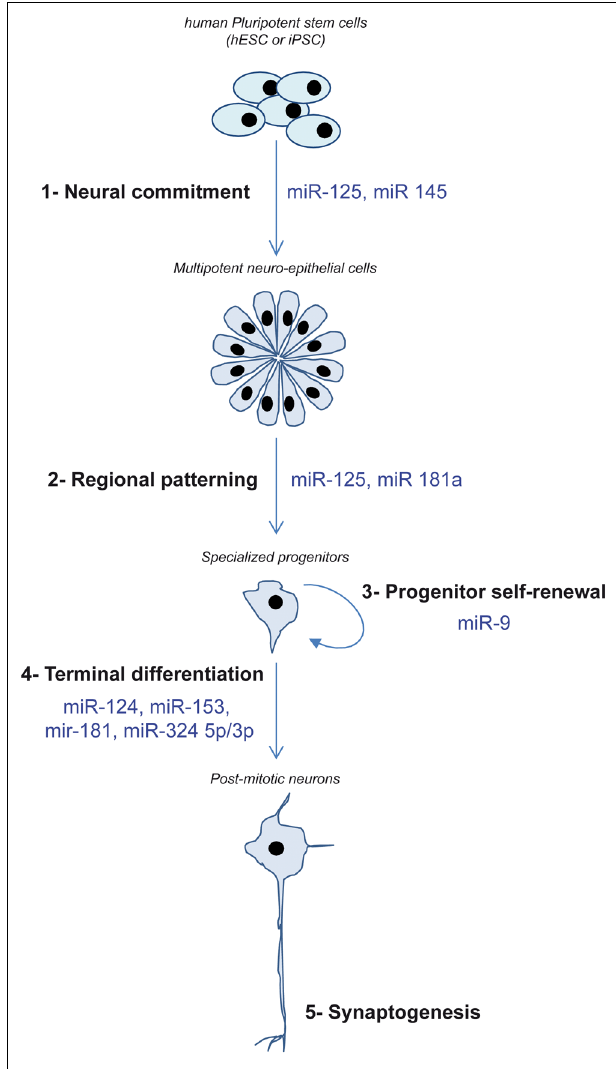
FIGURE 2 | Schematic depicting the different steps of neurogenesis recapitulated in vitro using hPSC and the miRNA demonstrated as regulators of these